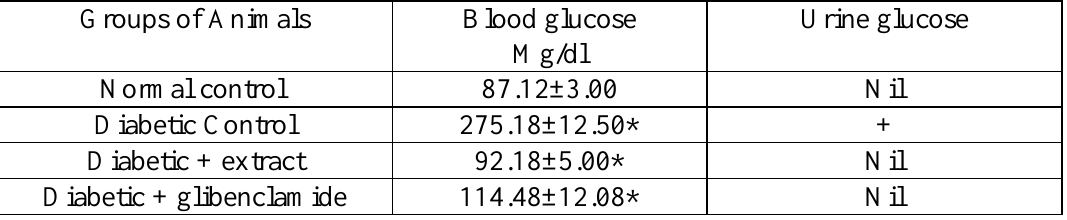
Table 1. Levels of blood glucose and urine glucose in control and experimental groups of